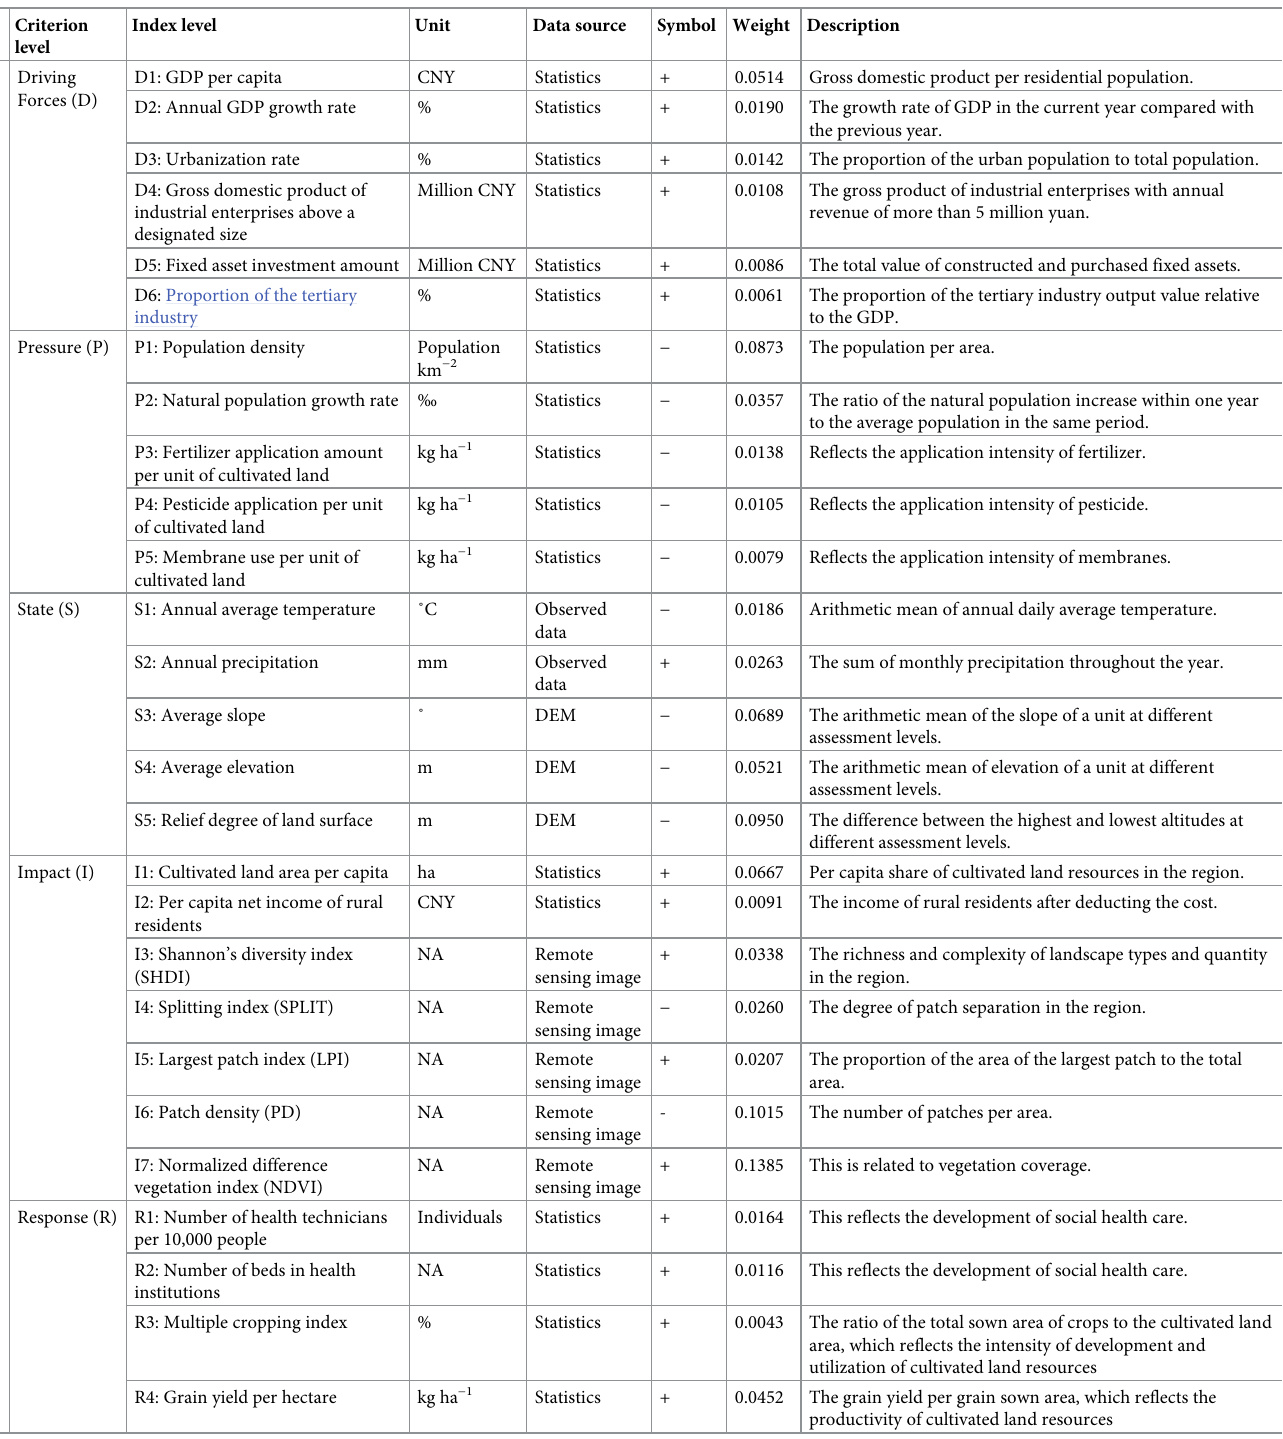
Table 1. Index system of ecological security assessment in central Yunnan Province